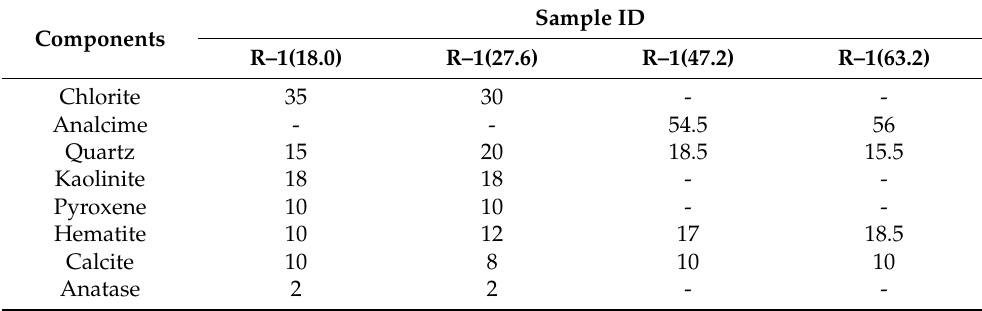
Table 5. Mineral composition of volcanic tuff core samples from Radoshivka–1 well (% w / w ).